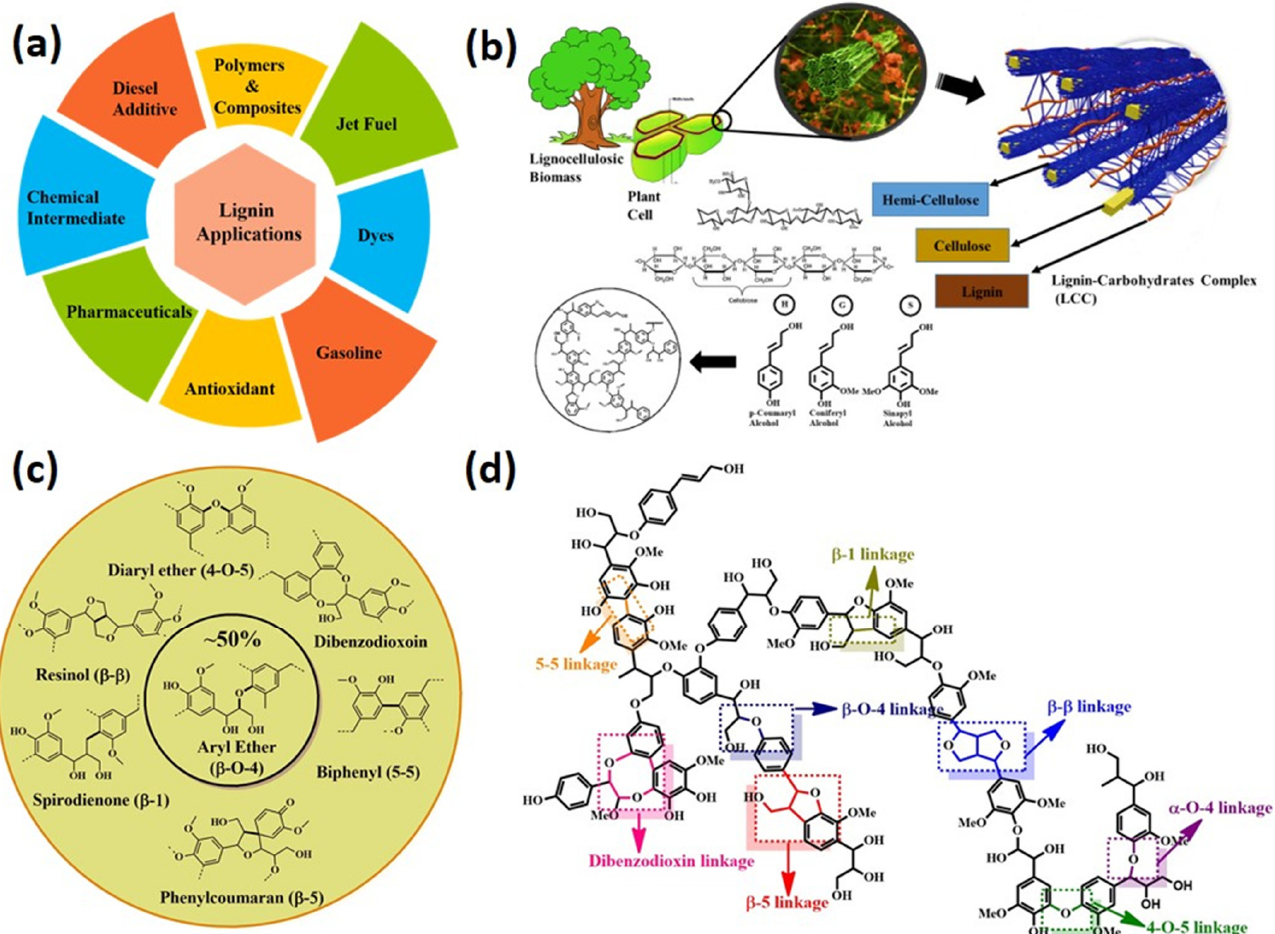
( c ) Linkages between lignin molecules. ( d ) Common structure of lignin